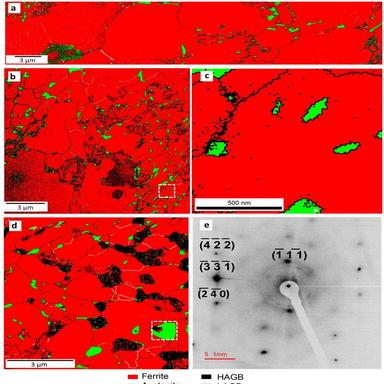
Phase maps obtained from TKD analysis in a) CH10-0.2s and UFH for 0.2 s (b & c), and 1.5 s (d)). Figure c) shows a detailed region in figure b). Figure e) represents the diffraction pattern of the austenite marked in figure d). Ferrite is shown in red and austenite in green. HAGBs are represented in black and LAGBs in white. Large regions in black are areas with a confidence index (CI) lower than 0.1. (For interpretation of the references to color in this figure legend, the reader is referred to the web ve